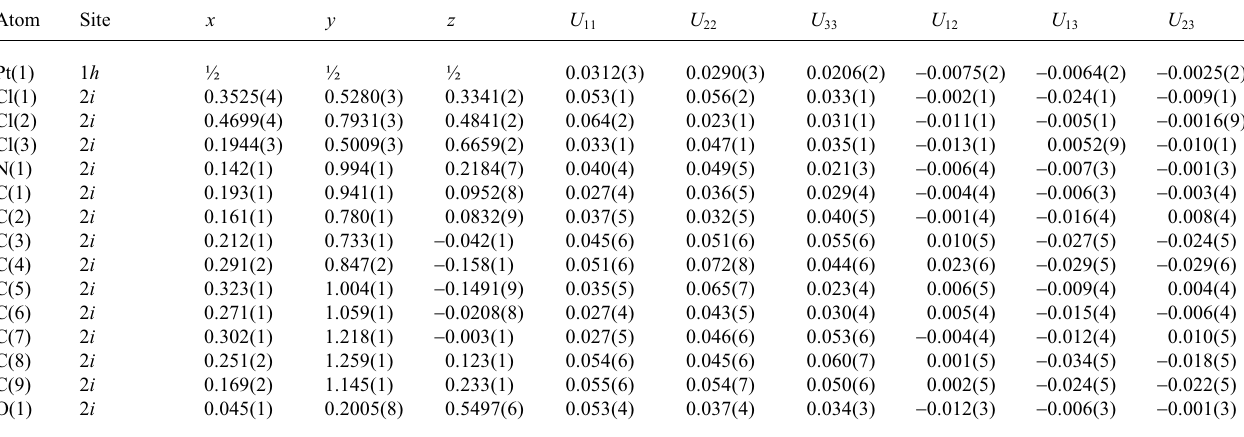
Table 3. Atomic coordinates and displacement parameters (in Å 2